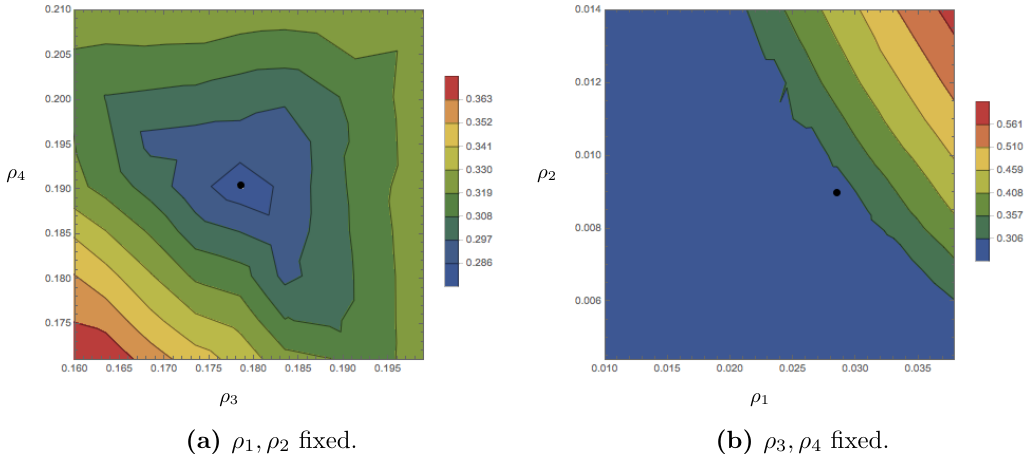
Figure 16 . Two 2-dimensional slices of the four dimensional moduli space through ^ (cid:26) (black dot in each (cid:12)gure). (cid:26) 1 ; (cid:26) 2 are (cid:12)xed at left, with (cid:26) 3 ; (cid:26) 4 (cid:12)xed at right. Numerical errors are less than 1% in the sense of appendix A. This level of error is consistent with some of the jagged features of the contours, though the existence of a local minima is robust to such